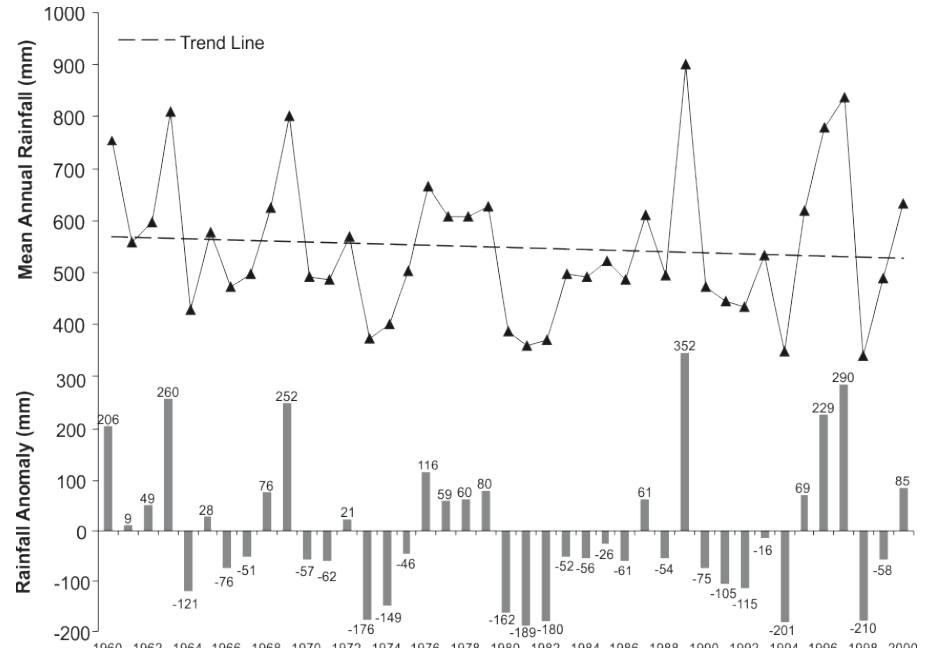
Fig. 1 Rainfall anomaly and mean annual rainfall for Cobres River basin between 1960 and